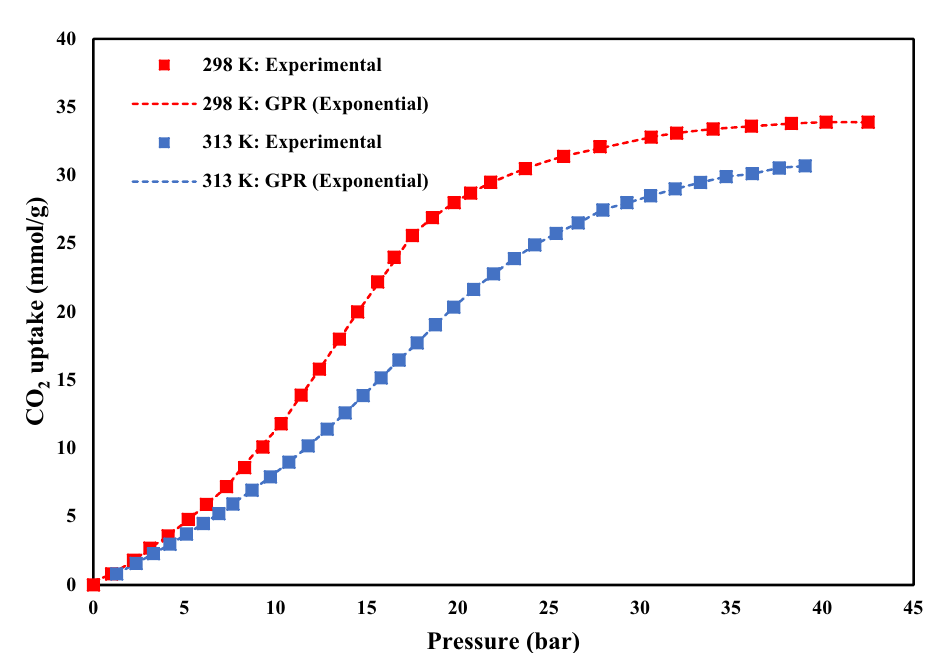
Figure 8. The CO 2 adsorption capacities of MOF-177 at 298 and 313